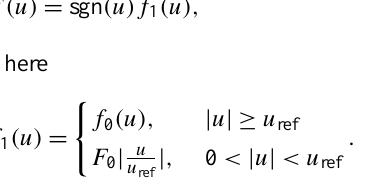
Figure 4. (a) illustrates a projection of the phase portrait p (Pa) vs. u ( m s − 1 ) of the deterministic system. (b) shows u ( m s − 1 ) as a function of t (s). These dependencies are plotted for different values V 0 : V 0 = 10 5 m 3 (blue), V 0 = 6 . 32 10 5 m 3 (red), and V 0 = 10 6 m 3 (green). ×